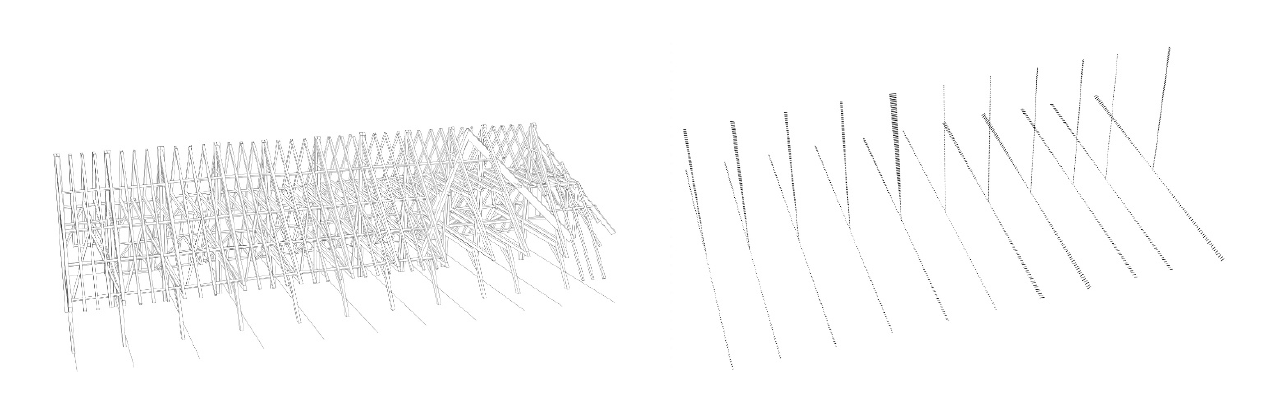
Figure 10. Geometrical deviation from the regular system of the Figure 9. 3D reconstruction of the truss of the Augustinian principal rafter trusses at Augustinian wing, Hofburg wing, Hofburg Vienna, based on a 3D laser scan survey © Karassew 2016